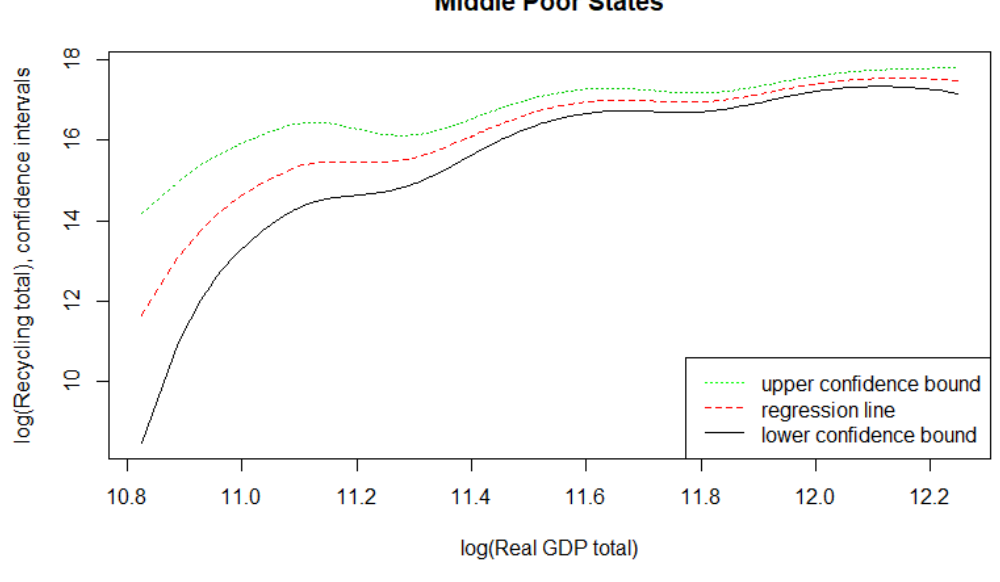
Figure 8. Relationship between total Recycling and total Real GDP for the middle poor